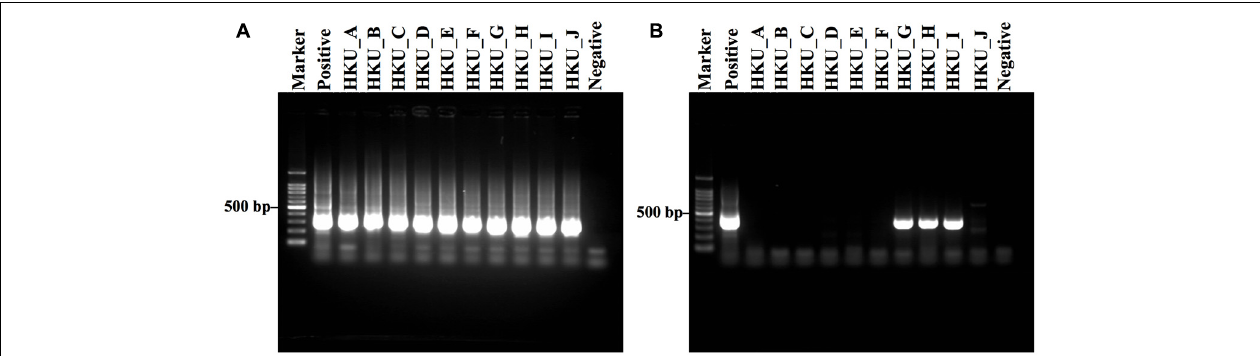
FIGURE 2 | Gel electrophoresis of DNA amplification by Legionella genus-specific and Legionella pneumophila - specific nested PCRs. (A) Amplification results of Legionella genus-specific and (B) L. pneumophila -specific nested PCRs are shown. Lane Marker: 100 bp DNA marker; lane Positive: L . pneumophila ;